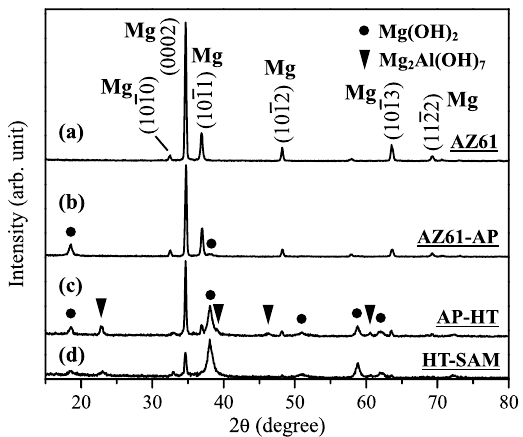
Figure 2. Grazing-incidence X-ray diffraction patterns of the AZ61 Mg alloy, AZ61-AP, AP-HT and